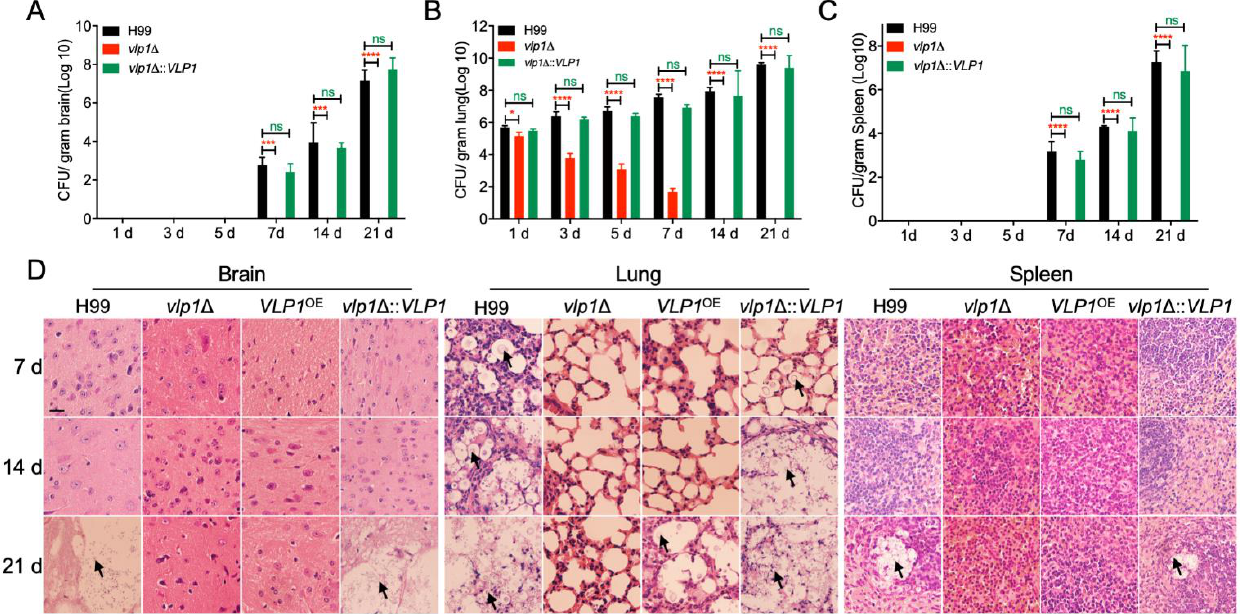
Figure 4. Progression of fungal infection in vlp1 Δ mutant infected organs. ( A ) Organs of five mice infected by each cryptococcal strain were isolated at 7, 14, and 21 dpi. CFU of each fresh organ was measured in the brain ( A ), lung ( B ), and spleen ( C ) homogenates. The data point shown is the mean ± SD for values from five mice. ns: not significant; *, p < 0.05; ***, p < 0;001; ****, p < 0.0001 (determined by Mann–Whitney test). ( D ) H&E-stained slides from the cross-sections of the organs prepared and observed under a light microscope. The cryptococcal cells are indicated by the arrow. Bars, 20 µm.